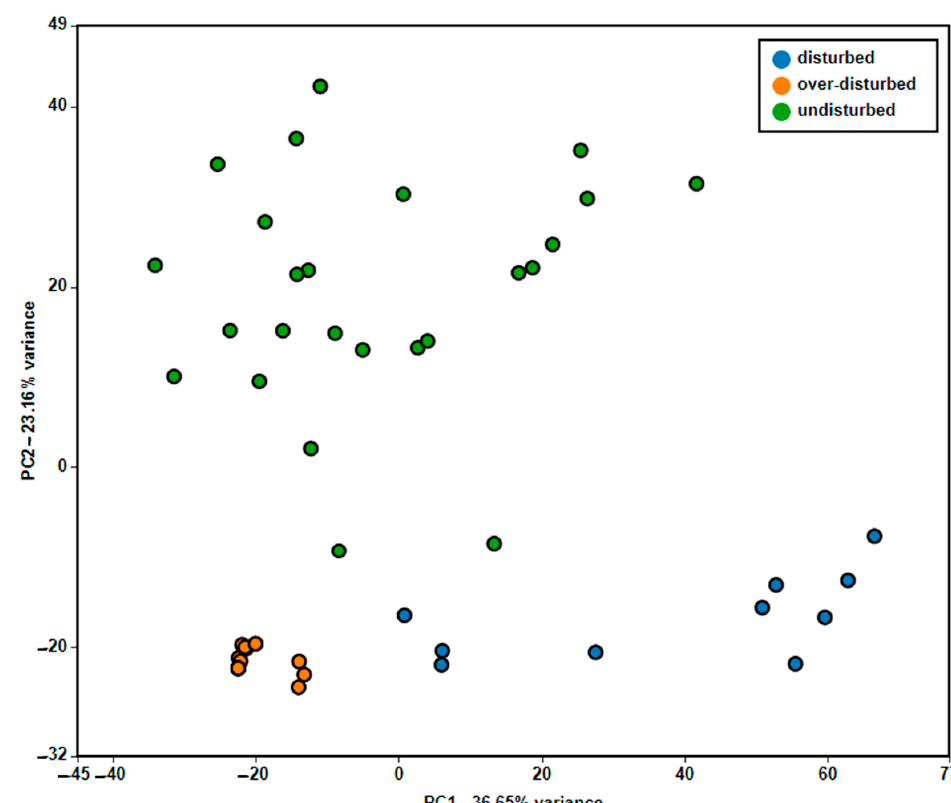
Figure 3. Principal component analysis (PCA) diagram of the vascular plant assemblage related to the disturbance levels in the study area.